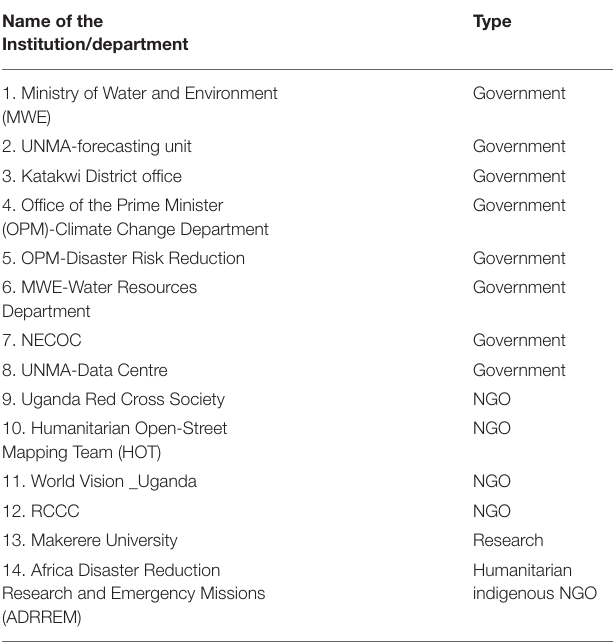
TABLE 1 | Institutions that took part in the online semi-structured